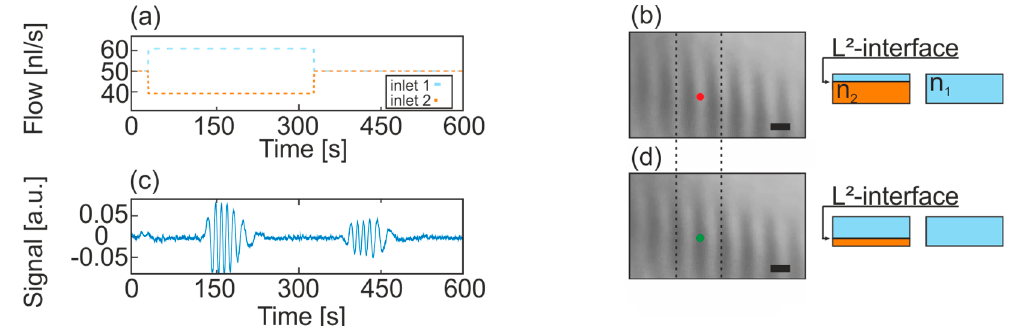
Figure 4. ( a ) Change in flow-rates of both inlets over time. ( c ) Background-subtracted signal of the CMOS-chip from one single pixel (compare with Figure 2). ( b , d ) Images taken from CMOS-camera at two different times (compare red and green dot in Figure 2) and L 2 -interface positions. The scale bar is 40